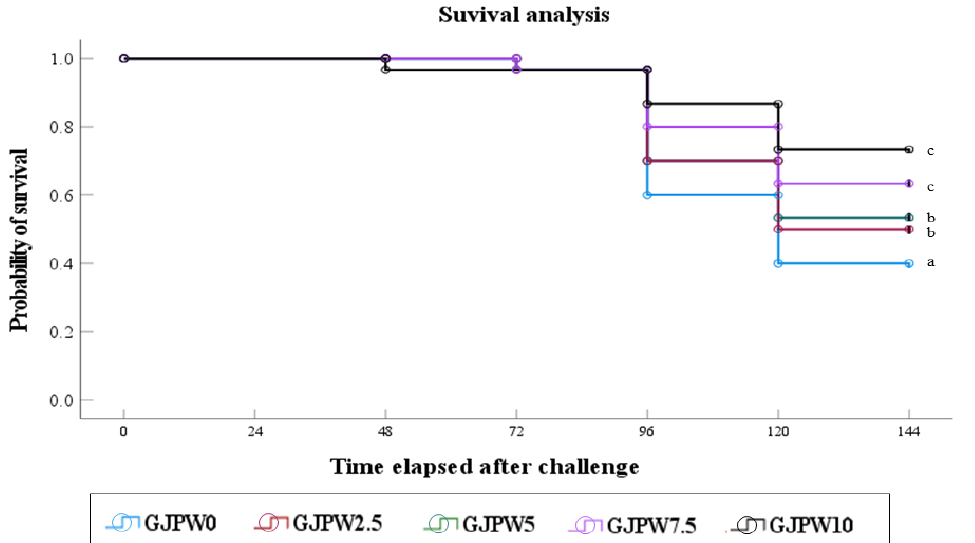
Figure 2. The survival of juvenile black rockfish fed experimental diets with different levels of inclusion of garlic juice processing waste (GJPW) for eight weeks and then infected by Streptococcus iniae . Values are means of triplicate groups. Different letters indicate significant differences ( p < 0.001; log-rank and Wilcoxon tests). GJPW: garlic juice processing waste.